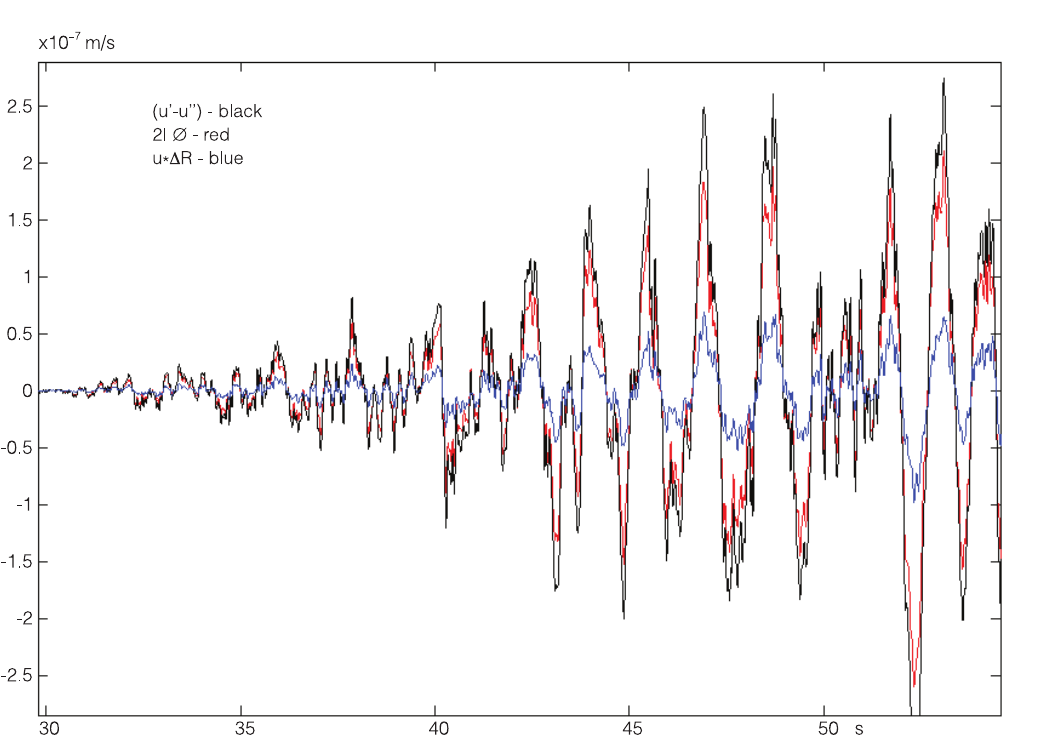
Fig. 5. Micro-displacement velocity, i.e . the difference between the displacement velocities recorded by the two anti-parallel sensors (black curve) and the corrected micro-displacement fi eld (red curve) and the computed errors due to response difference (blue